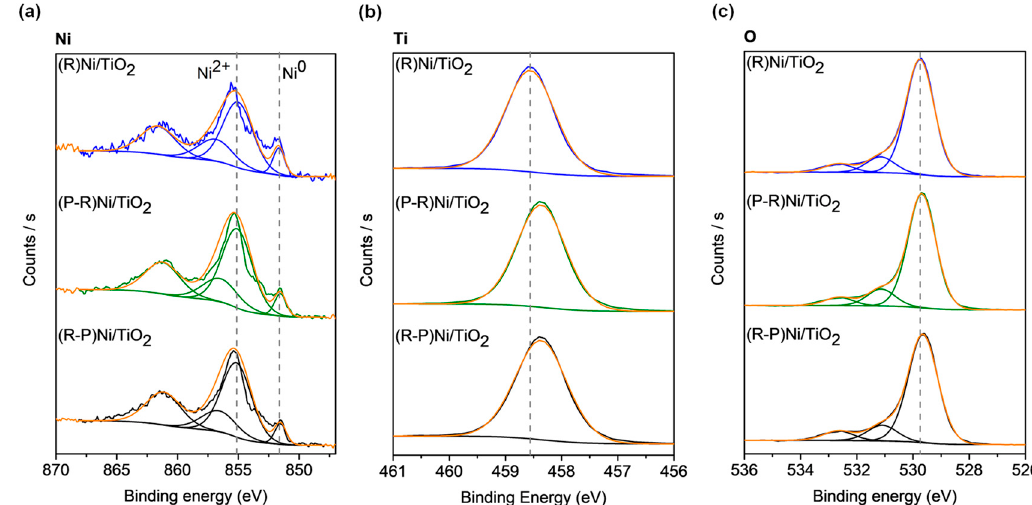
Figure 3. XPS spectra of pretreated Ni/TiO 2 : ( a ) Ni 2p 3/2 , ( b ) Ti 2p, and ( c ) O 1s. R = reduced/passivated, P = plasma treated.